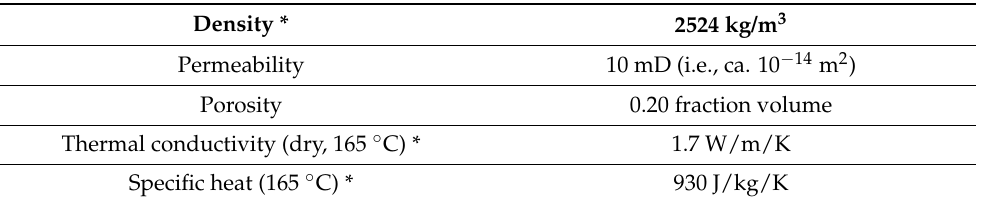
Table 4. The petrophysical rock properties of the Campanian Ignimbrite formation used for geochem- ical simulations.